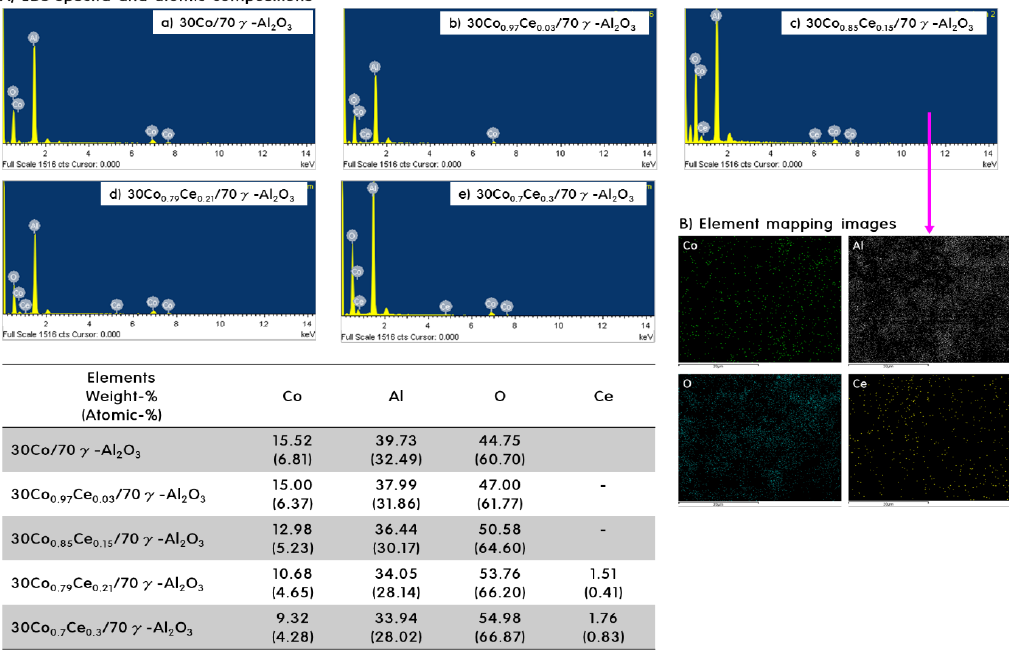
Figure 1. XRD patterns and TEM images of the fresh 30Co x Ce y /70γ-Al 2 O 3 catalysts.